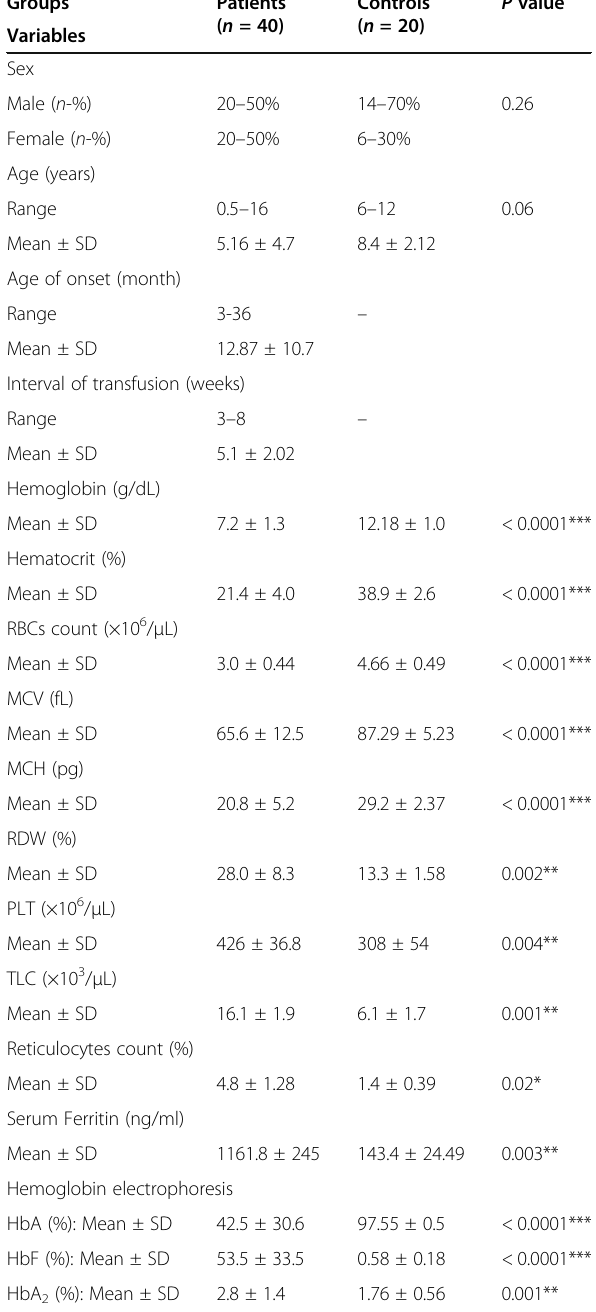
Table 1 Clinical data of the studied